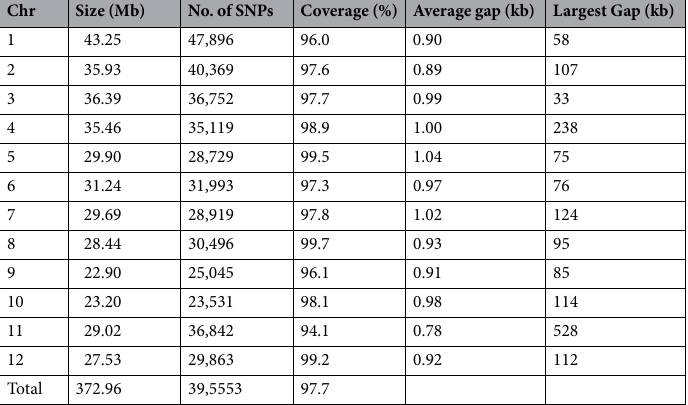
Table 3. Genome wide basic statistics of the SNP markers among the 208 rice germplasm